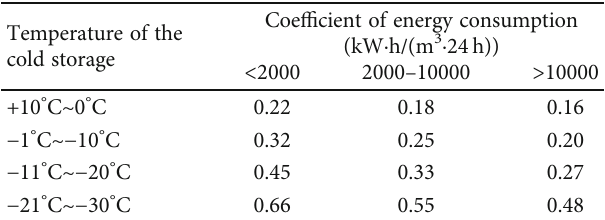
Table 7: Evaluation index value of standard energy consumption coe ffi cient of “ Energy Conservation Monitoring of Refrigeration Storage System ” in